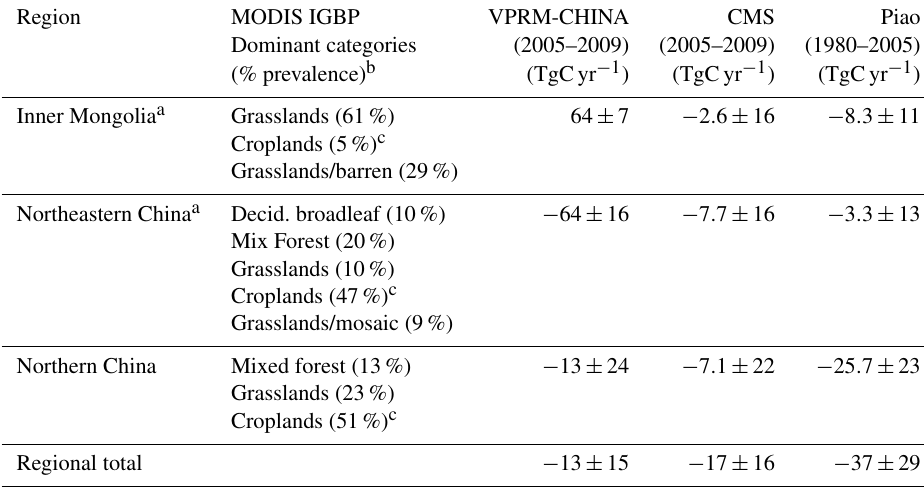
Table 4. Comparison of unoptimized VPRM-CHINA annual carbon exchange by region of China with other vegetation models. VPRM- CHINA and CMS values are reported as multiyear means ± 2 σ . Reported Piao values are the average of three approaches (process-based models, inverse approach, inventory approach).